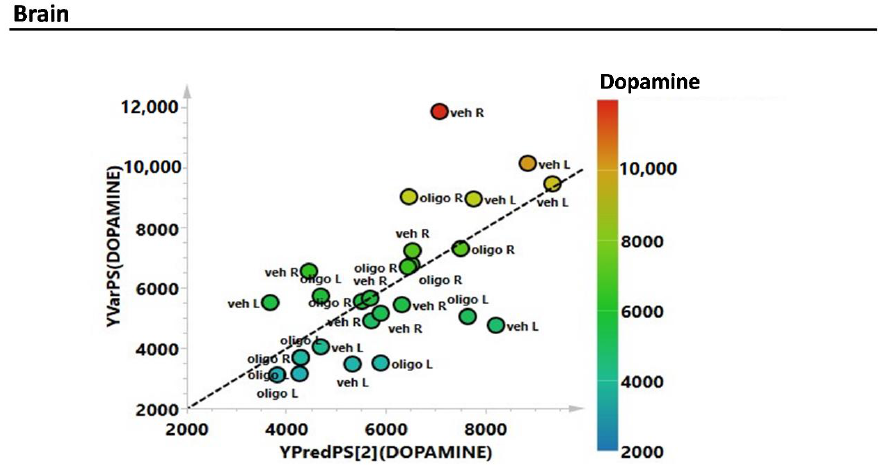
Figure 3. Partial least squares (PLS) correlation analysis of the complete metabolic profile of mesencephalon samples with striatal levels of DA (expressed as pg / mg tissue).